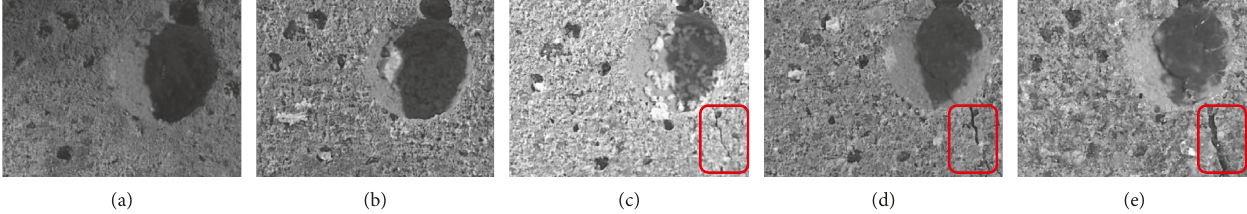
Figure 9: The microscope photographs of surface damage in concrete exposed to drying-wetting cycles with sulfate attack. (a) 0 days, (b) 21 days, (c) 42 days, (d) 54 days, and (e) 63 days.